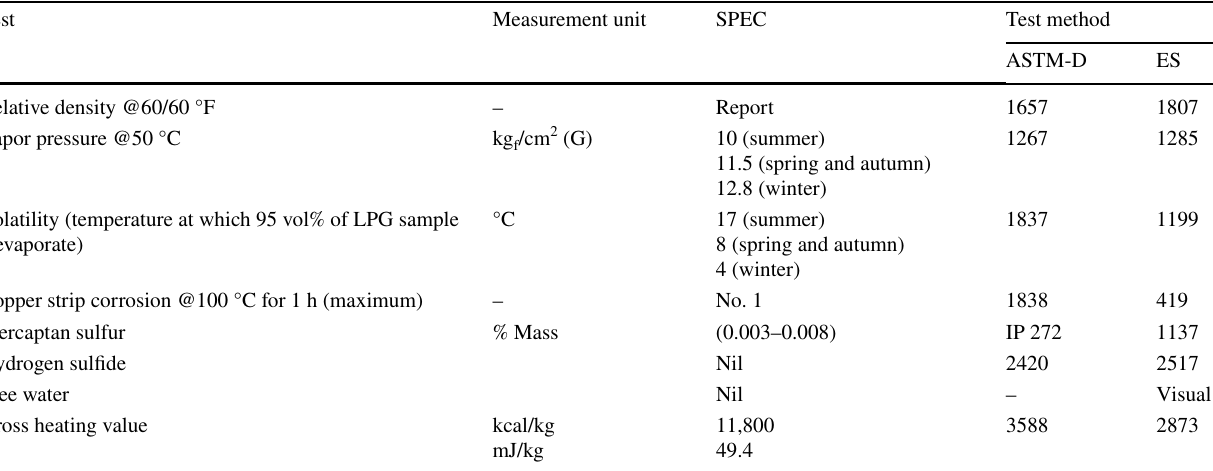
Table 1 Egyptian LPG specifications (Egyptian Organization for Standards and Quality)